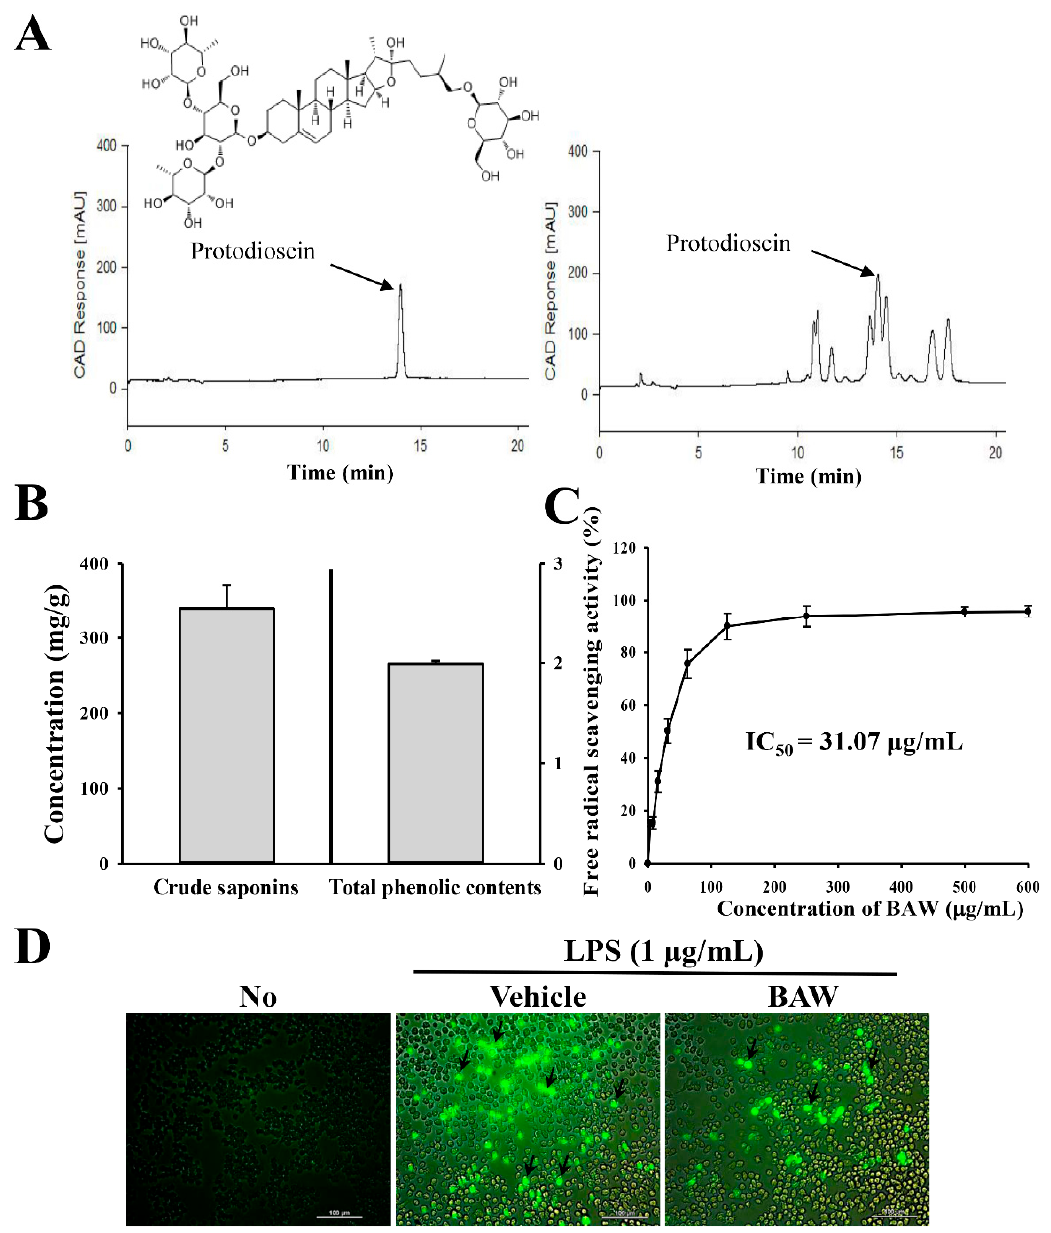
Figure 2. Antioxidant properties of BAW. ( A ) Chromatograms of protodioscin were obtained by performing high-performance liquid chromatography (HPLC) of BAW. The peak height/area reflects the concentration of protodioscin in BAW. ( B ) Crude saponins and total phenolic contents were analyzed in mixtures containing different concentrations of BAW. The contents of crude saponins were calculated using the following equation: crude saponins (mg/g) = A − B/S, where, A is the dry weight of the n-butanol layer (mg), B is the weight of the flask (mg), and S is the weight of the BAW extract (g). ( C ) Free radical scavenging activity of BAW. DPPH radical scavenging activity was assayed in a mixture containing 0.1 mM DPPH and varying concentrations of BAW (0 − 600 µ g/mL). The data represents the means ± standard deviation (SD) ( n = 8). DPPH, 2,2-diphenyl-1-picrylhydrazyl radical; IC 50 , half maximum inhibitory concentration. ( D ) Green fluorescence of ROS in cells co-treated with LPS and BAW was observed using fluorescence microscopy at 200 × magnification. Arrows indicate cells stained with DCFH-DA.